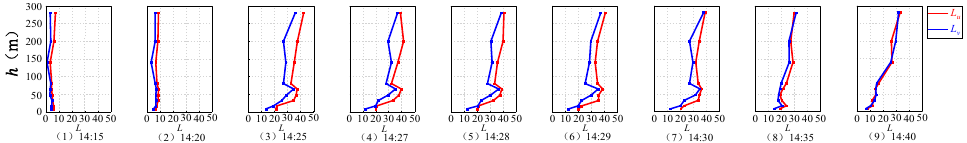
Figure 12. Spatial–temporal variation of longitudinal (red) and lateral (blue) turbulence integral length scale at some significant instants.